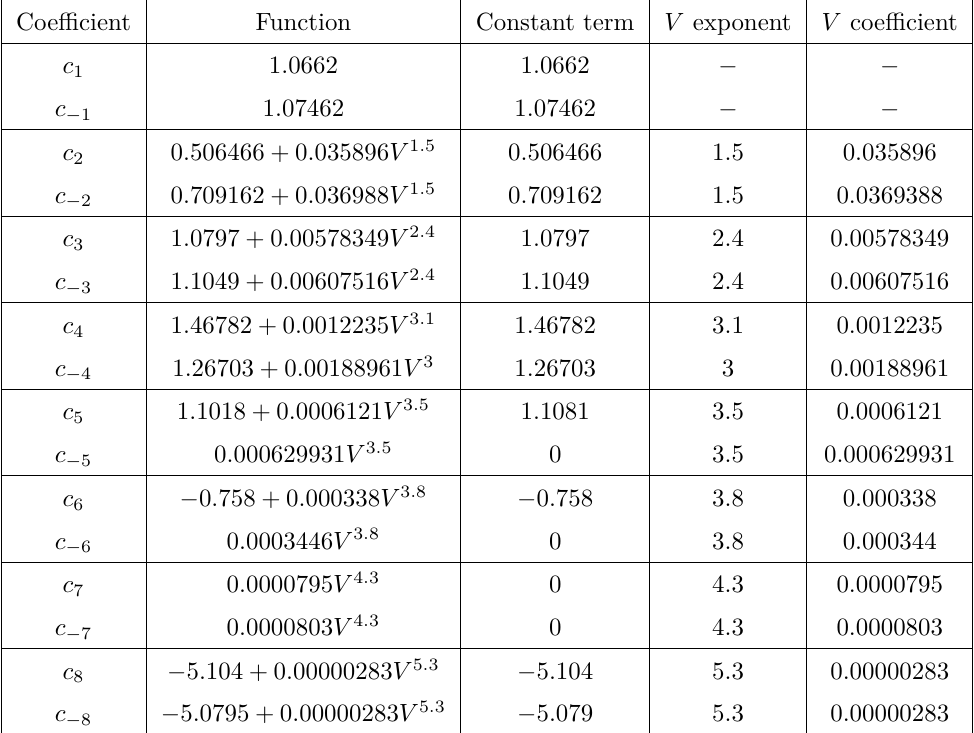
Table 2 . Fits for the mean absolute value of the coefficients as a function of the